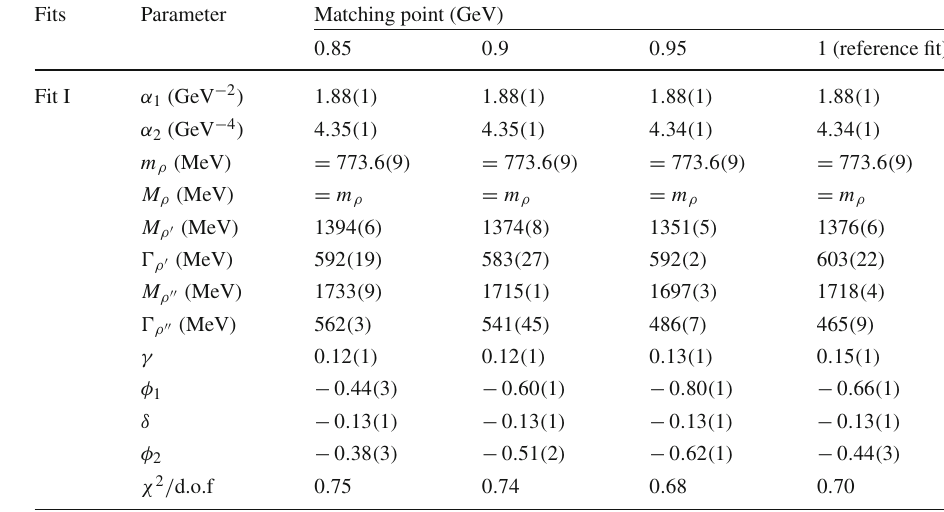
Table 2 Results for the fits obtained with a three-times-subtracted dispersion relation including three vector resonances in F π according to Eq.(26) with s cut = 4 GeV 2 in the dispersive integral for four representative values of the matching point